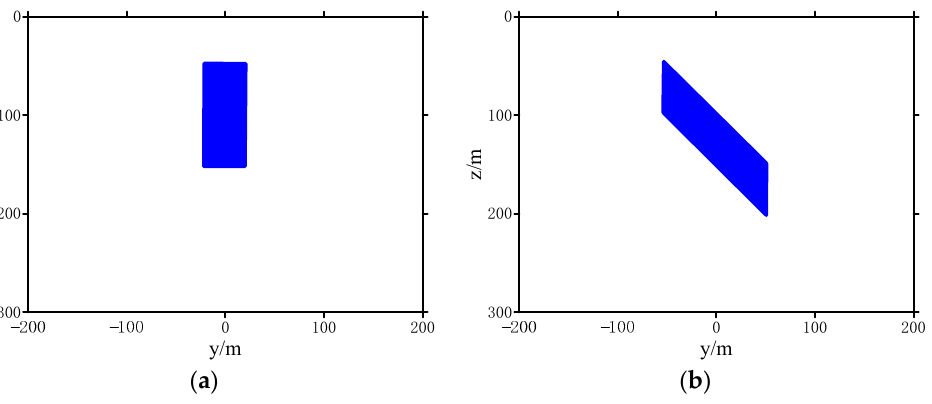
Figure 3. The cross-section through the x-axis of the 2D models. ( a ) Model 1, ( b ) Model 2. The norm p of the model objective function is 2, and only the positive constraint ( m ≥ 0 SI ) is imposed on the model, without the upper limit of magnetic susceptibility. The magnetic anomaly distribution of the model is shown in Figure 4.